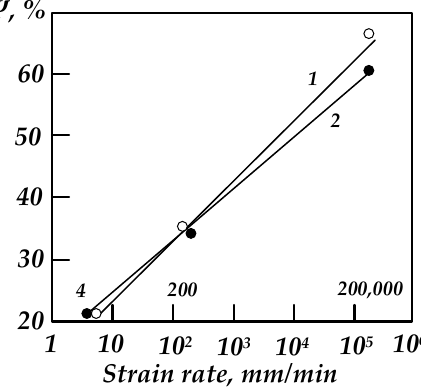
Figure 7. Influence of the strain rate on the relative narrowing of hydrogen-saturated Armco-iron samples: at 2 h electrolytic saturation (1); at high temperature (2) [26]. samples: at 2 h electrolytic saturation (1); at high temperature (2)